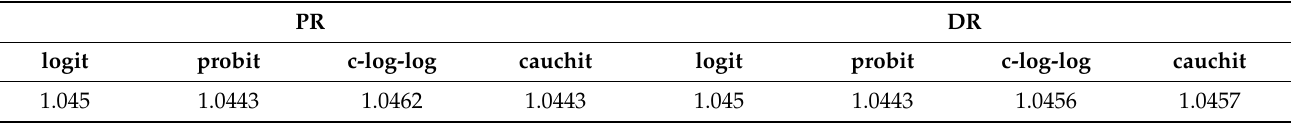
Table 1. Constants for the logistic regression profiling with ARL 0 = 200 under various link functions.